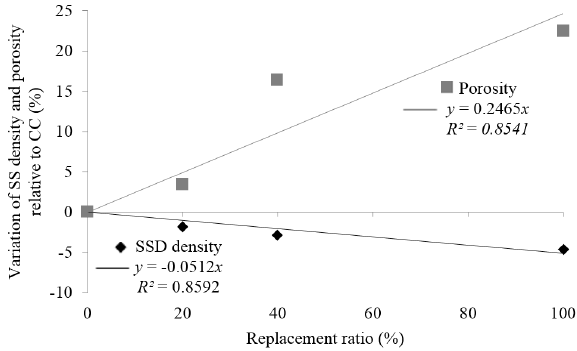
Figure 10. Loss of mean of SSD density and porosity variation relative to CC in relation to the replacement ratio.